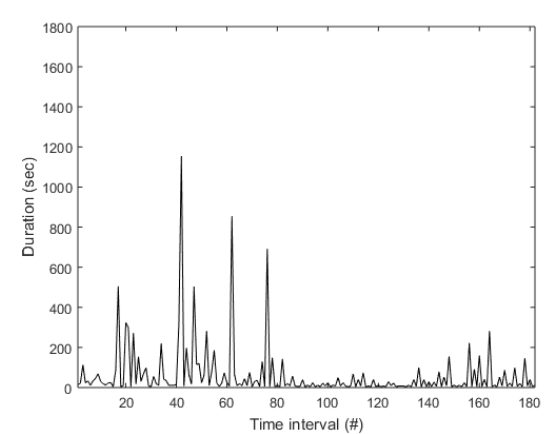
Figure 8. Example of the time-intervals signal.